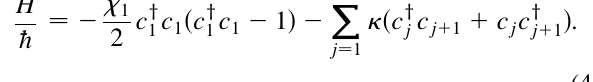
(cid:1) 0 : 25 is a characteristic constant of the ABH Fig. 2. (cid:4) 1 that is largely independent of lattice size [5,7]. When (cid:4) < (cid:4)